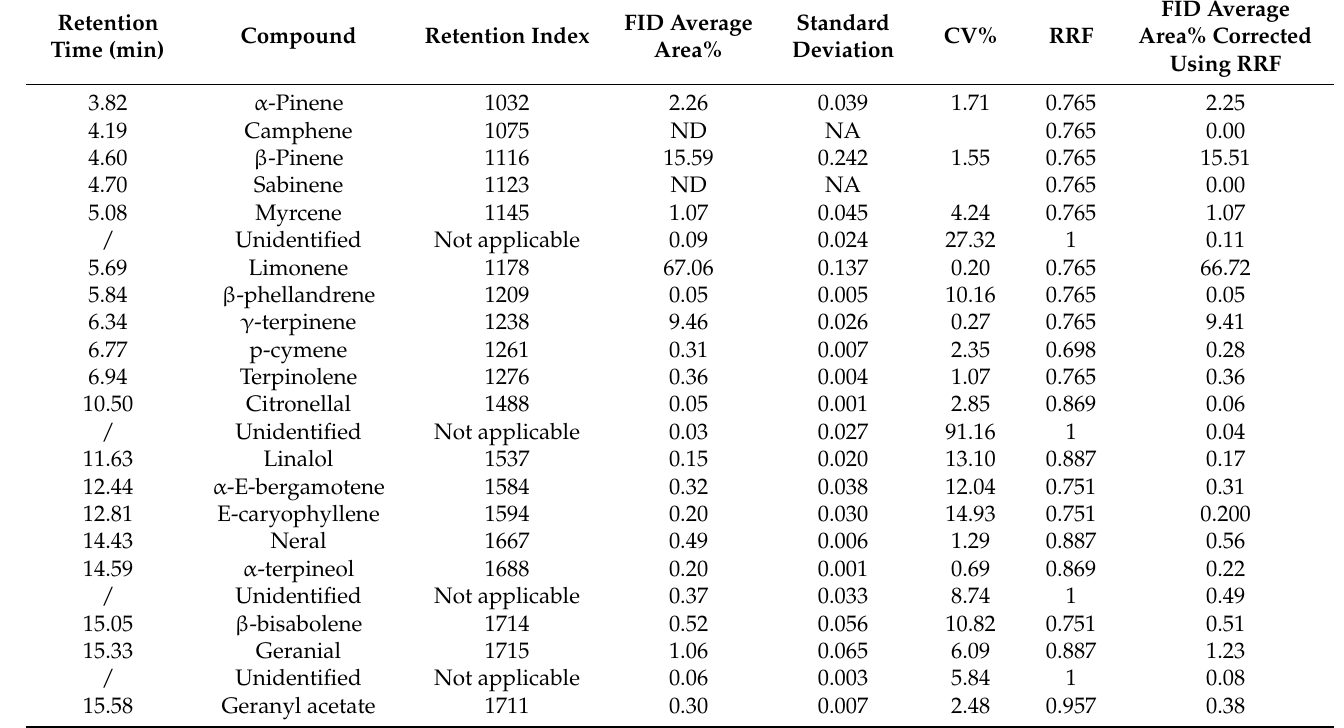
Table 1. Chemical compositions (area %) of lemon essential oil using GC-FID data, relative measure of the dispersion of data around the mean (CV%) calculated using ratio of the standard deviation to the mean, predictive response factors for gas chromatography with flame ionization detection RRF (relative response factor), corrected FID area percentage using RRF